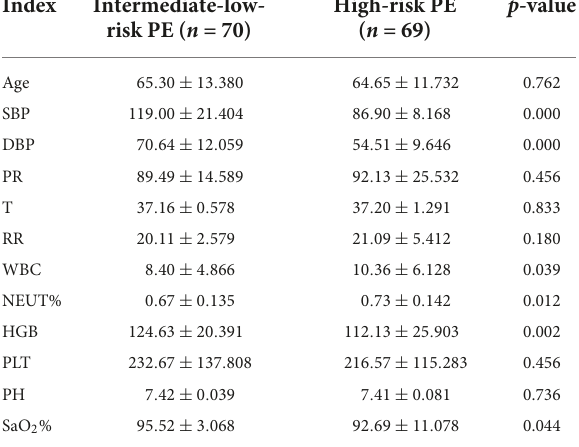
TABLE 3 Blood routine, arterial blood gas analysis and clinical parameters in intermediate-low-risk PE patients and high-risk PE patients.